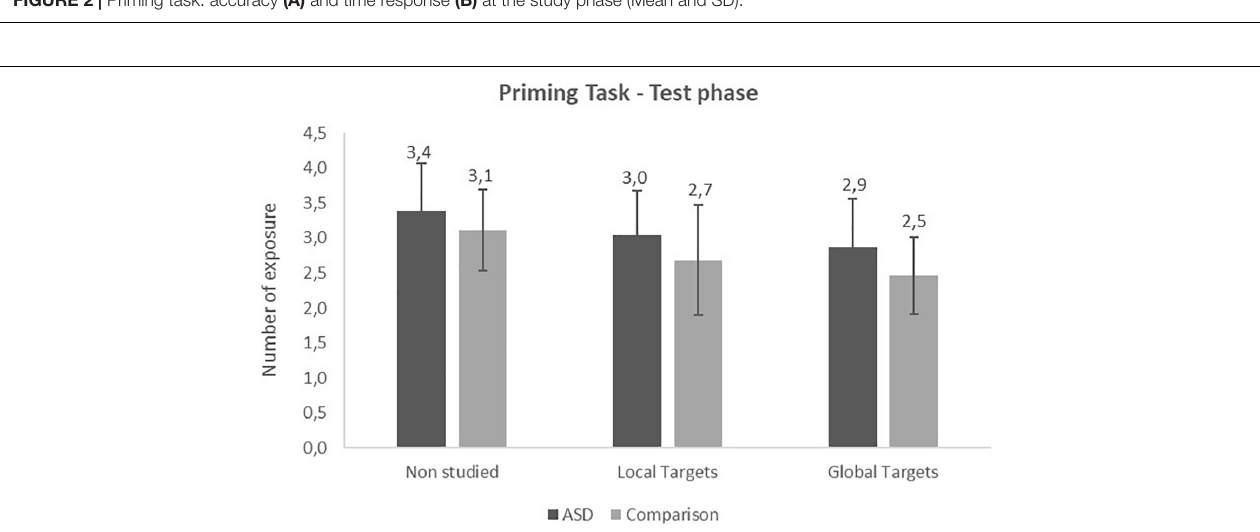
FIGURE 2 | Priming task: accuracy (A) and time response (B) at the study phase (Mean and SD).